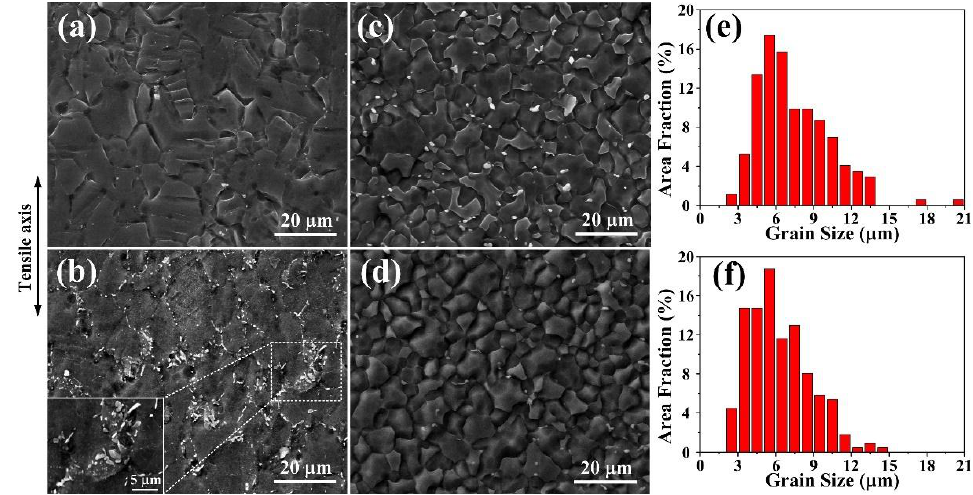
Figure 6. SEM micrographs of the fractured samples in the gauge section after tensile deformation of ( a ) extruded, ( b ) DA-54h at room temperature and ( c ) extruded, ( d ) DA-54h at 300 °C with corresponding grain size distribution in ( e , f ), respectively.